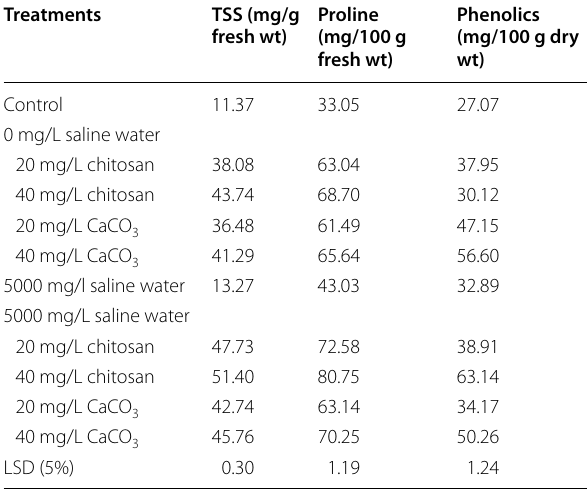
Table 5 Effect of chitosan and calcium carbonate (0, 20 and 40 mg/L) on osmo-protectants (TSS mg/g fresh weight, proline mg/100 g fresh weight and phenolics mg/100 g dry weight) contents of wheat plant growing under different salinity levels